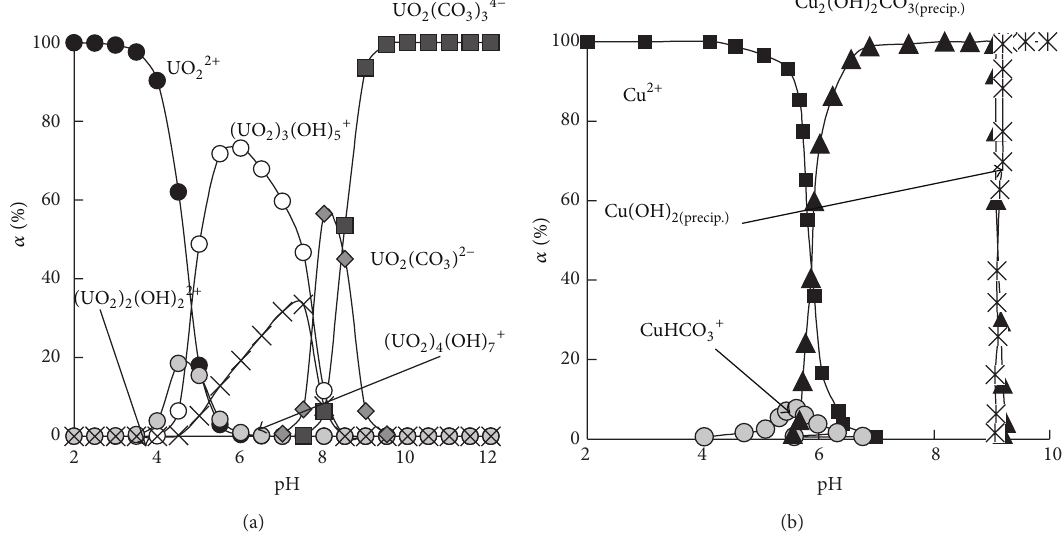
= 10 −3 M; 𝐶 = 𝐶 = co 32− ) U ( VI ) Cu ( II )